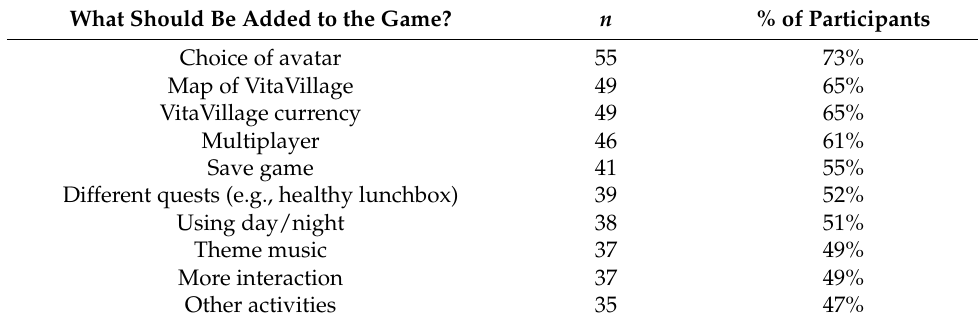
Table 2. Preferred additions to be made to the game, according to the participants. What Should Be Added to the Game?